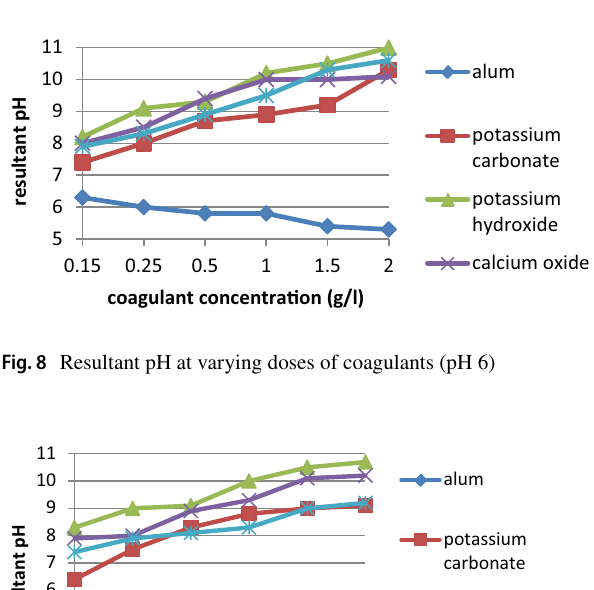
Fig. 7 Resultant pH at varying doses of coagulants (pH 7)